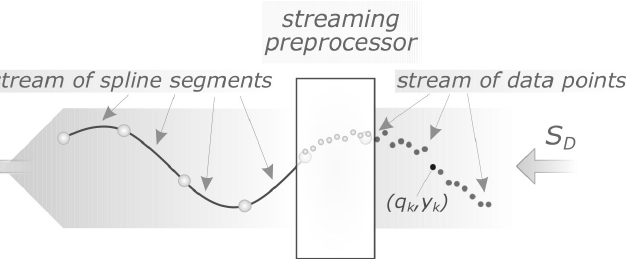
Figure 1. Conceptual diagram of the considered problem: the streaming preprocessor (segmenter) maps a stream of data points to a stream of cubic spline segments , which form a C 2 -continuous